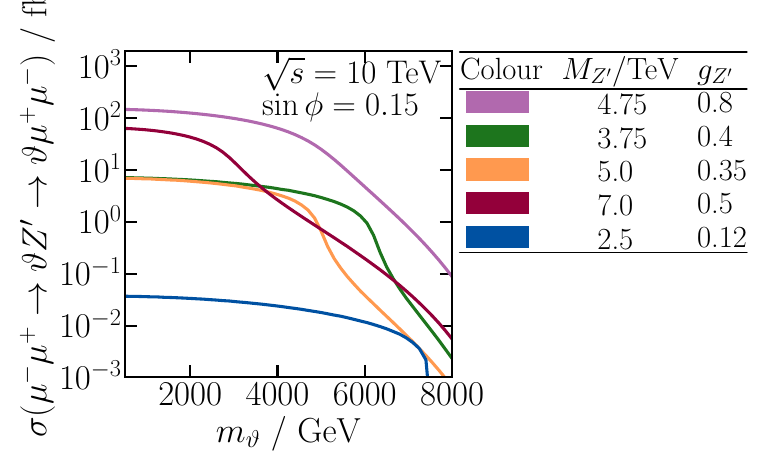
Figure 14. Tree-level flavonstrahlung cross-sections for 10 TeV µ + µ − collisions for q θ = 1 . Each coloured line corresponds to a parameter point labelled by a star of the same colour in figure 10. The cross-sections do not include ISR